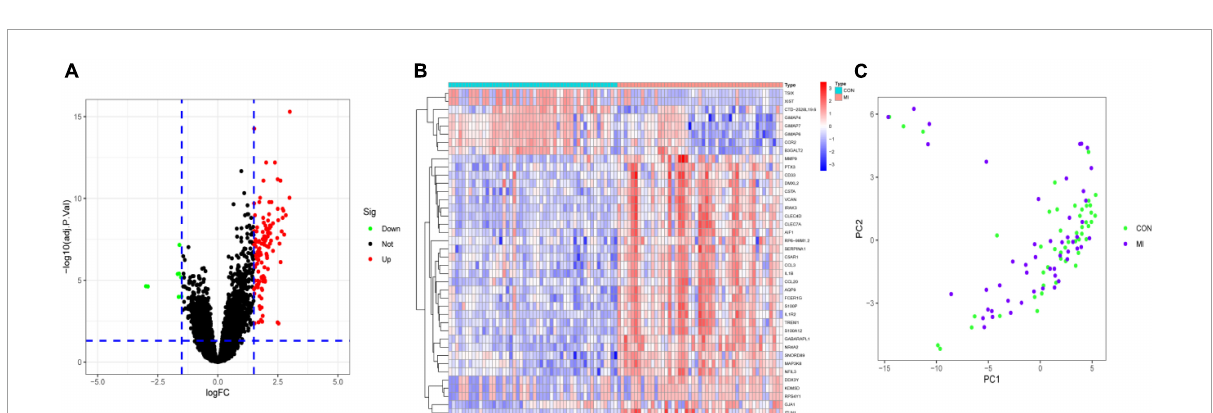
FIGURE1 The flowchart of this study.